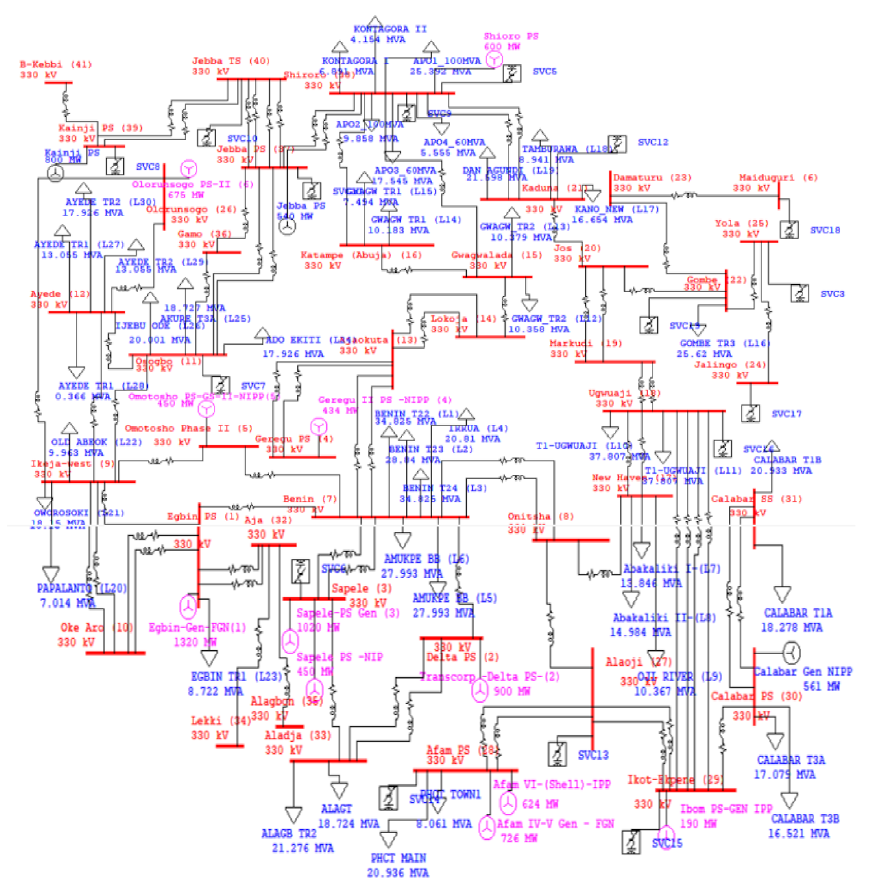
Figure 10. Compensated 41 bus Nigerian 330 kV transmission network [22].